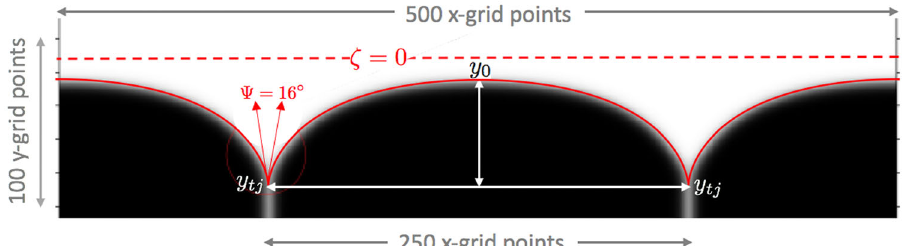
Fig. 4 Comparison of a multiphase- fi eld simulated image of a periodic GBG with its variational sharp-interface counterpart, the μ - η pro fi le (red curve). To achieve the fi t shown in the fi gure, uniform magni fi cation was applied to the isometric μ - η pro fi le, calculated with the same dihedral angle used in the simulation, viz., Ψ = 16 deg. The value of Ψ is the only parameter shared between models. The goodness of fi t between the simulated GBG image and its sharp-interface pro fi le is estimated from their respective aspect ratios, A and ^ A , where, A is measured on the phase- fi eld image, and ^ A is calculated from Eq. (7) for the variational pro fi le. The A -value was measured using the white-arrow distances shown on this image, and a matching ^ A -value was calculated from Eq. (7) using iterated η 0 values. η 0 converged to − 0.095, a value estimated to be accurate to three signi fi cant fi gures. The quality of the fi t between models is limited by the pixel resolution of the interfacial isolines that de fi ne the phase- fi eld image. The broken red line represents the theoretical position of the melting point isotherm, or isopotential, ζ = 0, where a fl at s / ℓ interface would reach